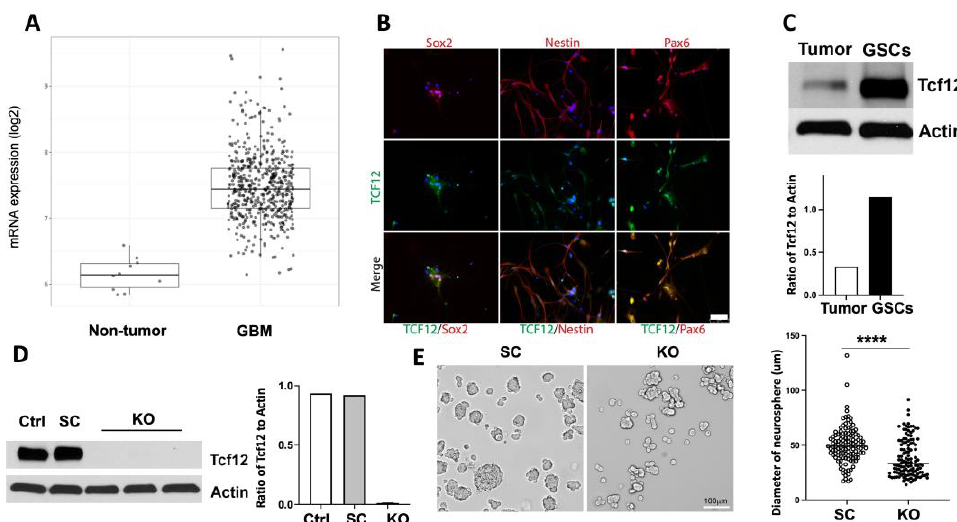
Figure 1. TCF12 is upregulated in human GBM cells and is specifically enriched in GSCs. ( A ) mRNA expression plot shows higher TCF12 expression in human GBM cells compared to normal nontumor cells. Source: http//gliovis.bioinfo.cnio.es. ( B ) Representative immune staining of human glioblastoma stem cells (GSCs) showing co-localization of TCF12 with known stem cell markers Sox2, Nestin, and Pax6. ( C ) Western blot and quantification showing enrichment of TCF12 in human GSCs compared to the original tumor samples from which they were enriched. See also Figure S1A,B. ( D ) Western blot and quantification showing deletion of TCF12 in GL261 using the CRISPR/Cas9 system. These are single knockout clones. Ctrl: control, SC: scramble, KO: knockout. The uncropped blots are shown in Figure S1. ( E ) Bright field pictures showing neurosphere formation by scramble and TCF12 KO GL261 cells. Neurosphere sizes are quantified based on the particle size. ****, p < 0.0001. Scale bar: 5 µm in ( B ), 100 µm in ( E ).